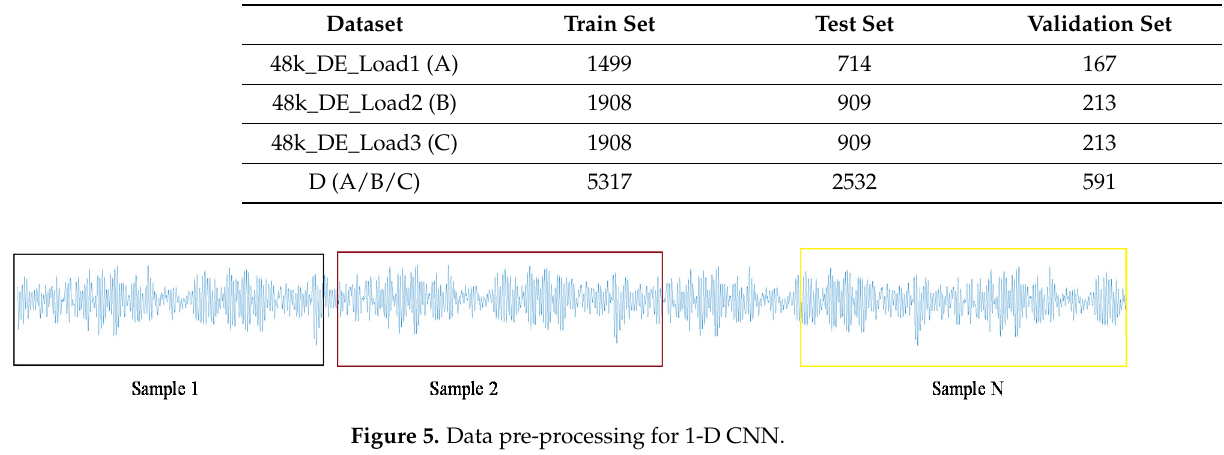
Figure 5. Data pre-processing for 1-D CNN. Table 2. Length of train, test, and validation set used in the research.